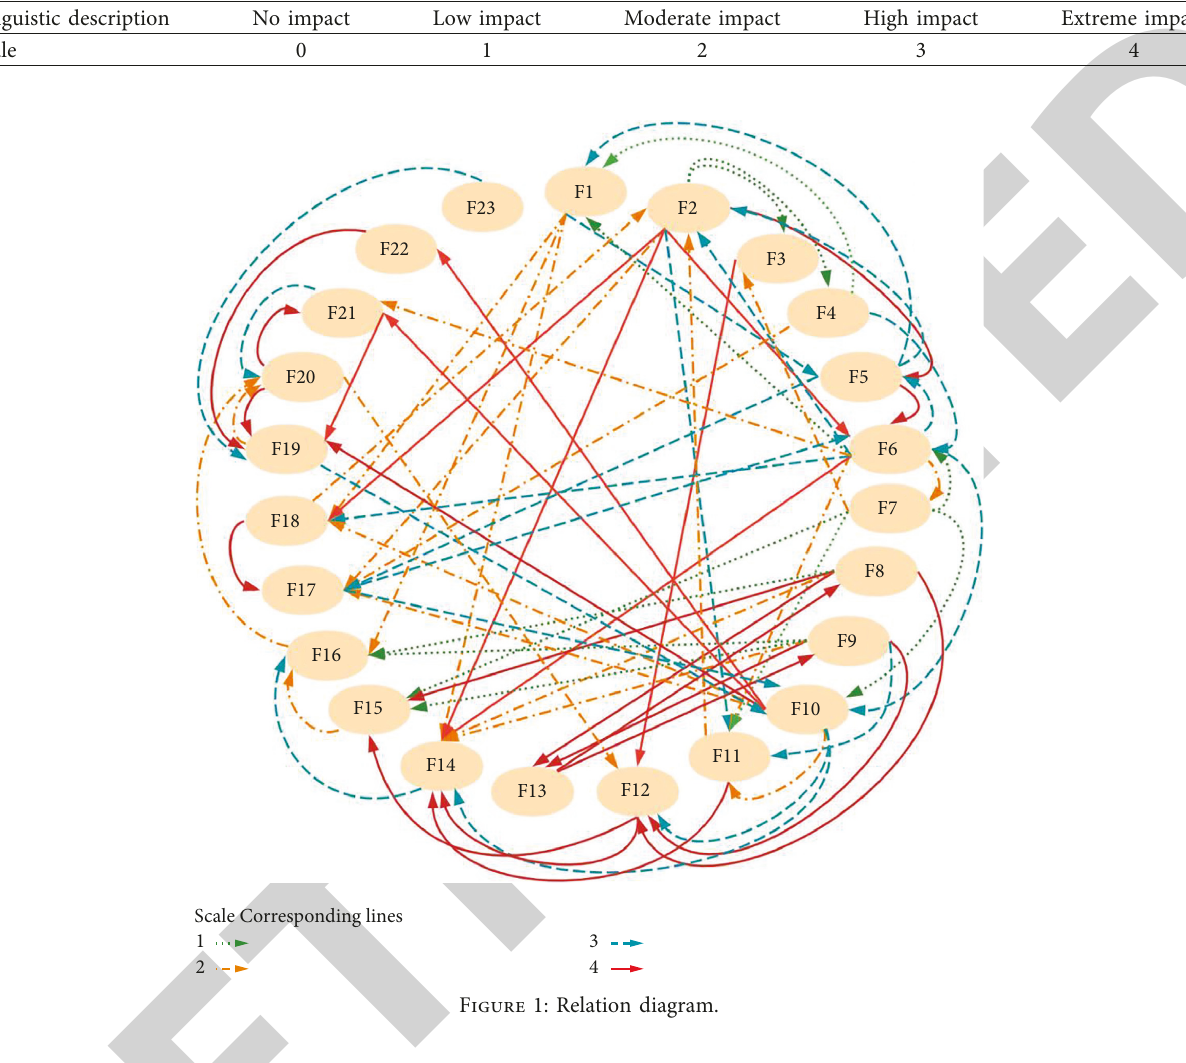
Table 2: Expert evaluation scale.